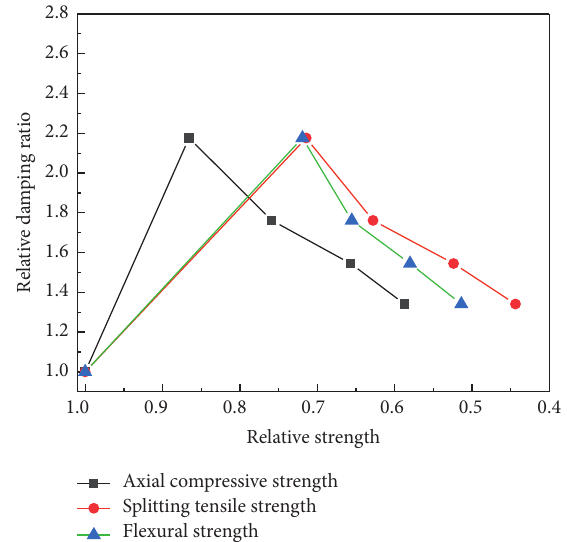
Figure 13: Relationship between relative damping ratio and var- ious mechanical parameters.